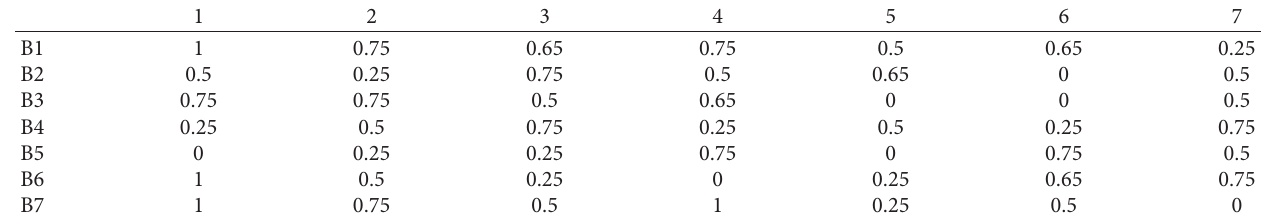
Table 2: Input data.